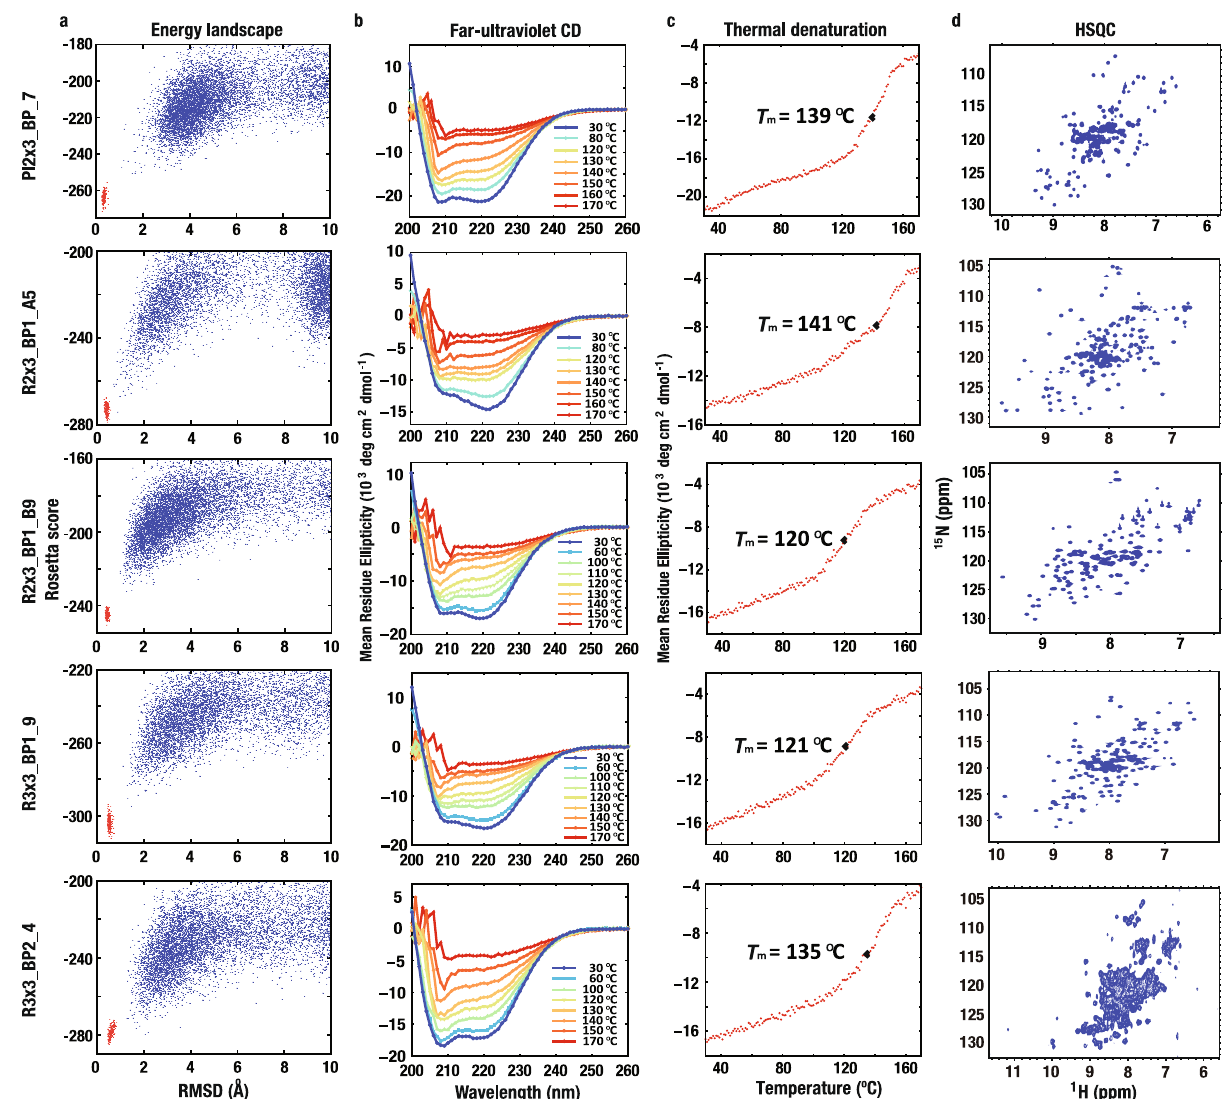
Fig. 2 Design characterization. a Energy landscapes from Rosetta ab initio structure prediction simulations. Blue points represent the lowest energy structures obtained in independent Monte Carlo structure prediction trajectories starting from an extended chain for each sequence; the y-axis is the Rosetta all atom energy, the x-axis, the root mean square deviation (RMSD) to the design model. Red points represent the lowest energy structures obtained in trajectories starting from the design model. b Far-ultraviolet circular dichroism (CD) spectra at temperatures up to 170 °C and c Thermal denaturation curves at 222 nm with the transition midpoint temperature, T m . d Two-dimensional 1 H- 15 N HSQC spectra at 25 °C and 600